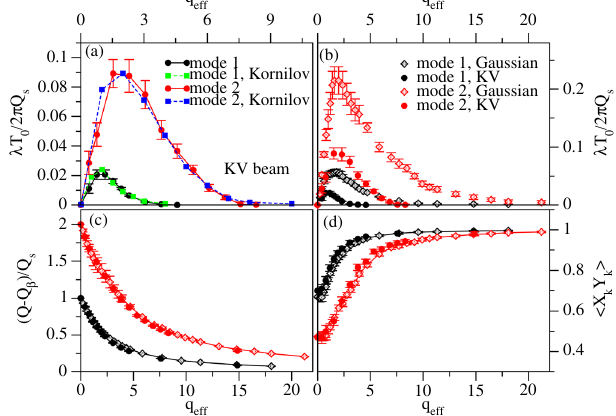
FIG. 9. (a) Landau damping for KV-G bunches. Comparison between our simulations and those of Kornilov and Boine- Frankenheim [9]. The agreement is good. (b) – (d) Comparison between the first two modes of KV-G beams and 3D-G beams. (b) Landau damping. The damping of the 3D-G beams ’ modes is much larger. (c) Relative tune shift. (d) Spatial overlap of the mode shape with the space charge harmonic [see Eq. (32)]. Unlike the Landau damping the tune shift and the modes shapes depend very little on the transverse beam distribution, as